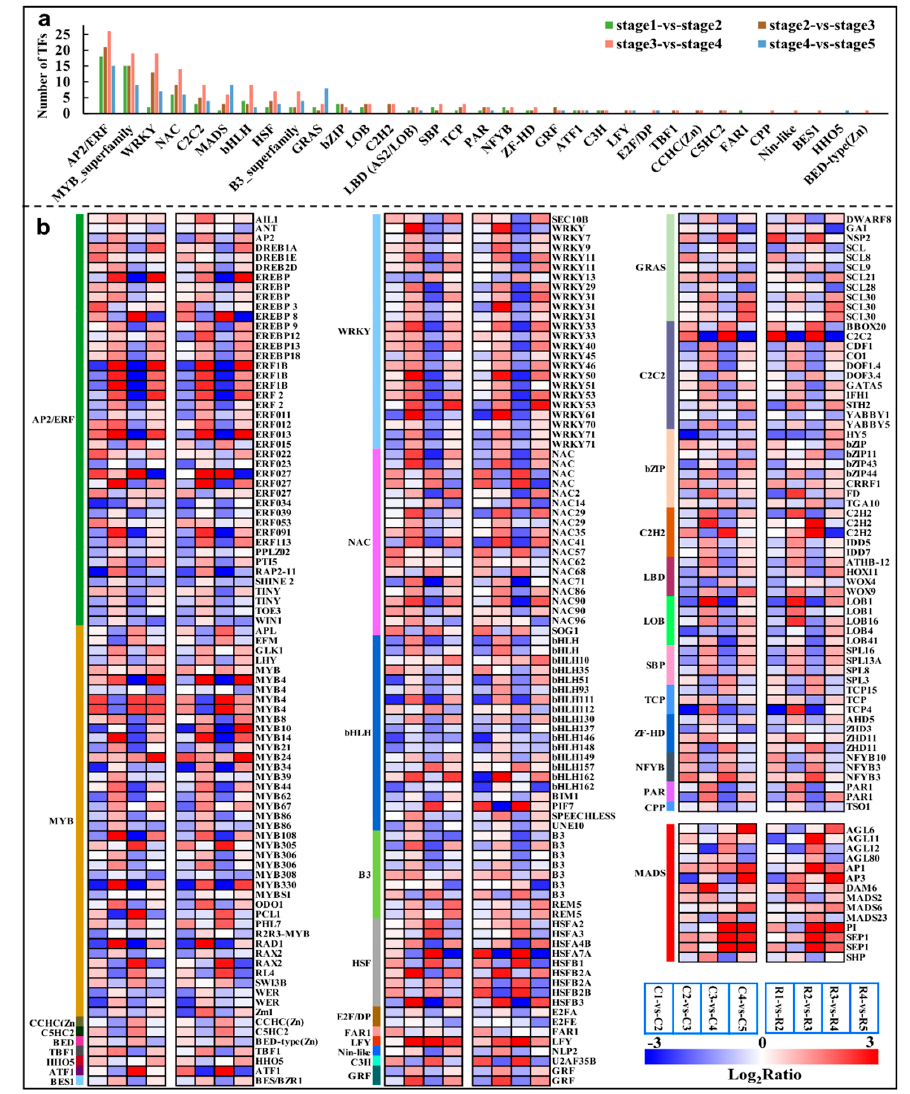
Figure 7. The types and numbers of TFs families in different comparison groups ( a ), and the relative expression of all identified TFs in either of the four comparison groups ( b ). Color codes from blue to red indicate changes in transcriptional expression levels between − 3 and